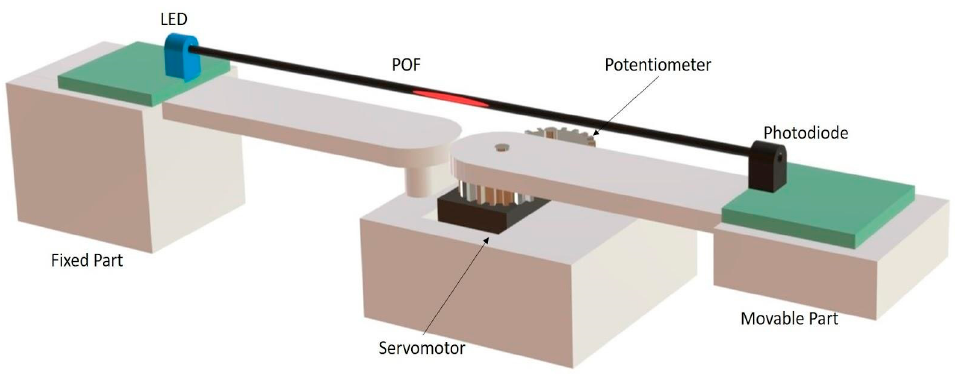
Figure 2. Test bench applied on the tests.